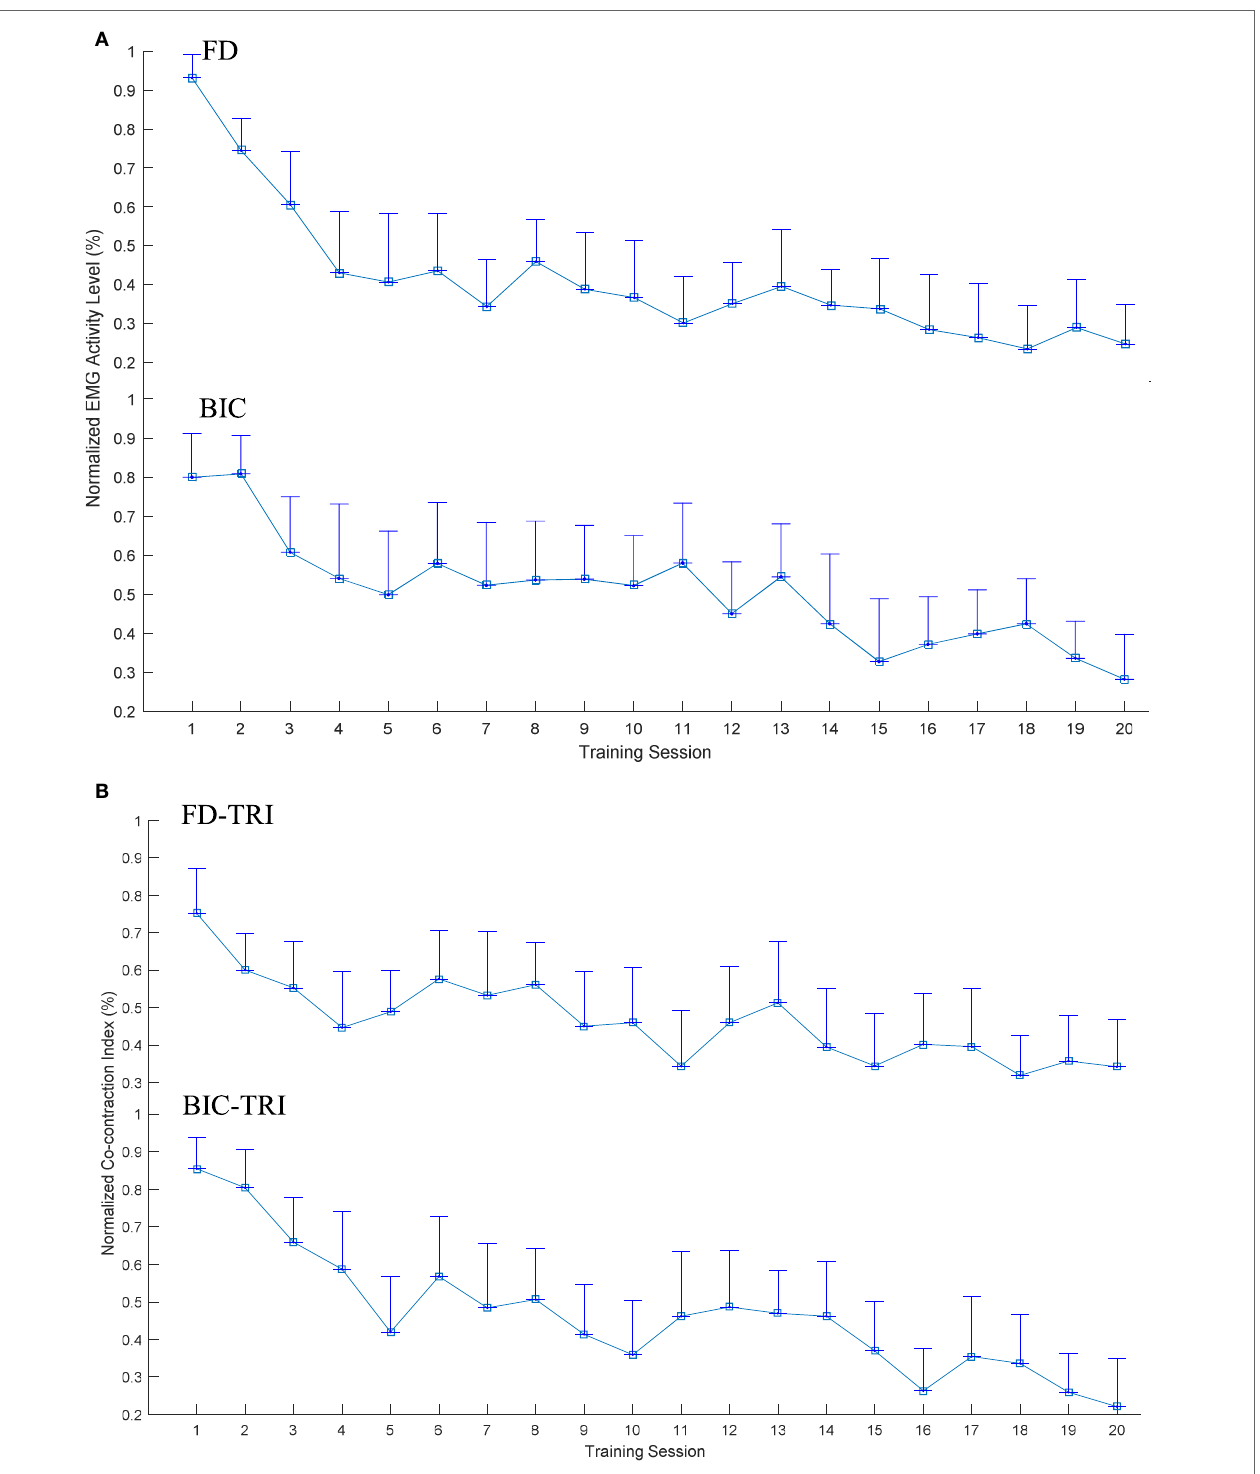
FiGUrE 5 | The variation of electromyography (EMG) parameters recorded across the 20 training sessions associated with significant decreases ( P < 0.05 with one-way analysis of variance with Bonferroni post hoc tests): (a) the normalized EMG activation levels of the flexor digitorum (FD) and BIC muscles during the bare hand evaluation. (B) The changes of the normalized Co-contraction Indexes of the FD and TRI and BIC and TRI muscle pairs with statistical significance during the bare hand evaluation. The values are presented as mean value with two times SE (error bar) in each